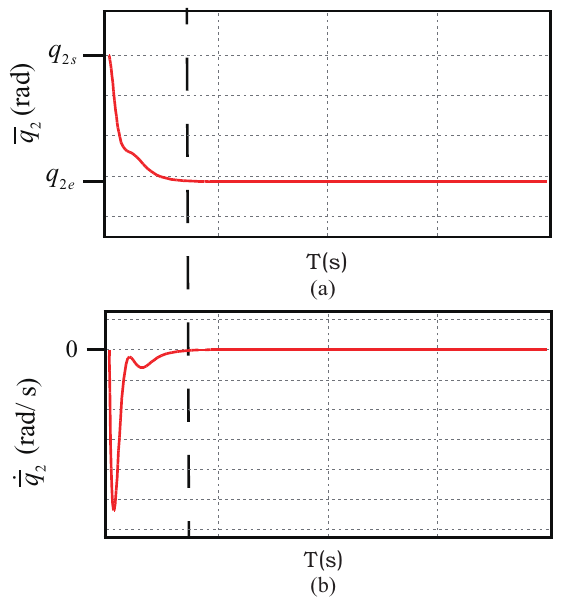
Figure 2. Planned trajectory: ( a ) angle; ( b ) angular velocity.